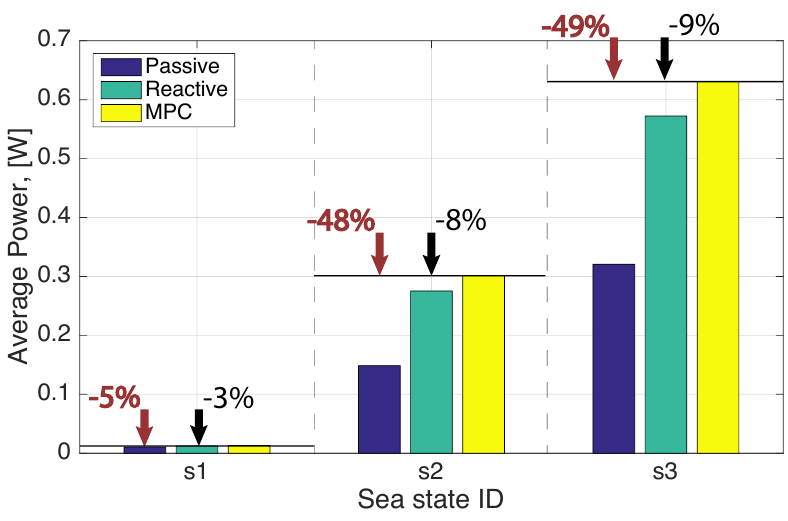
Figure 10. Power performance as a function of the sea state for a passive controller, reactive controller and the MPC.